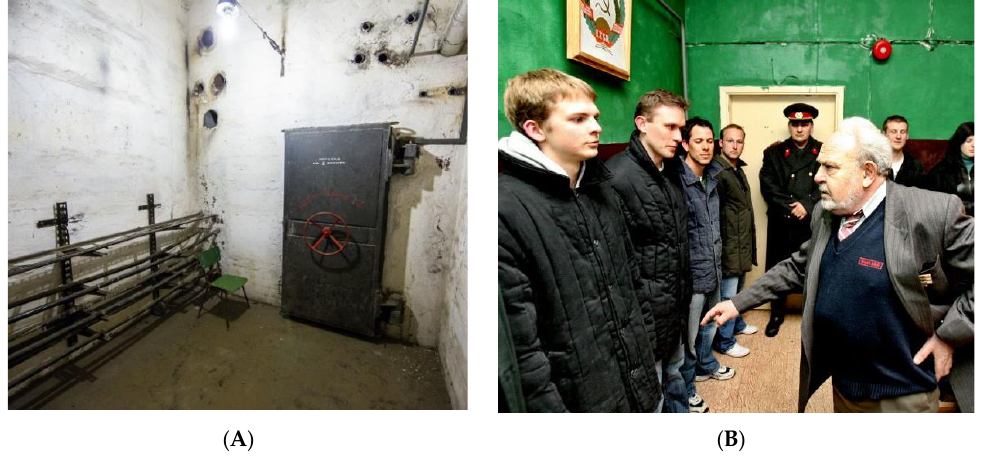
Figure 15. ( A ) Soviet bunker ‘House of Creation’. Available online: https://tinyurl.com/36kt673r (accessed on 21 March 2022); ( B ) Scene from ‘1984. Survival Drama’. Available online: